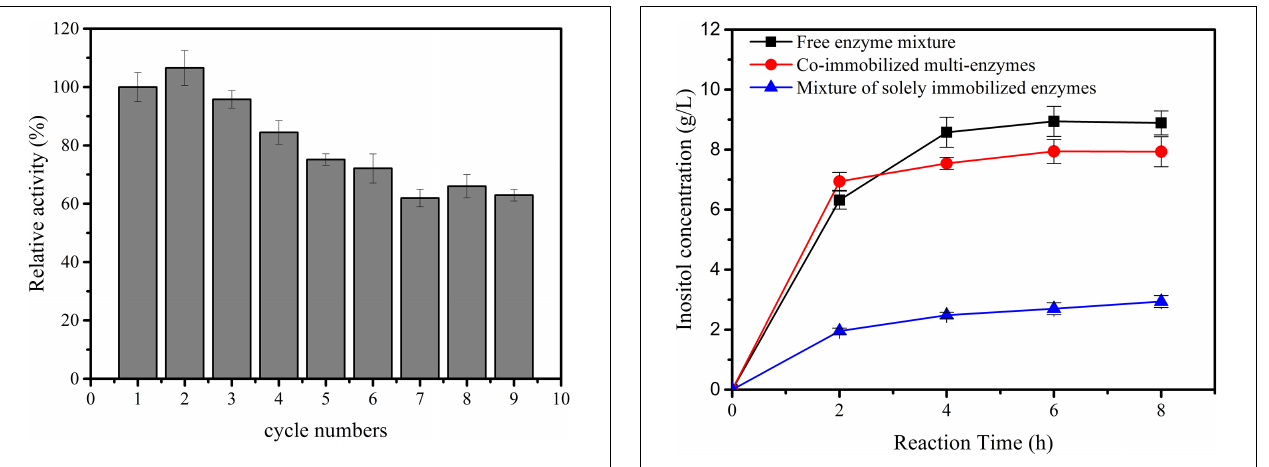
FIGURE 5 | The inositol production as a function of the reaction time catalyzed by free enzyme mixture, co-immobilized multi-enzymes, and mixture of solely immobilized